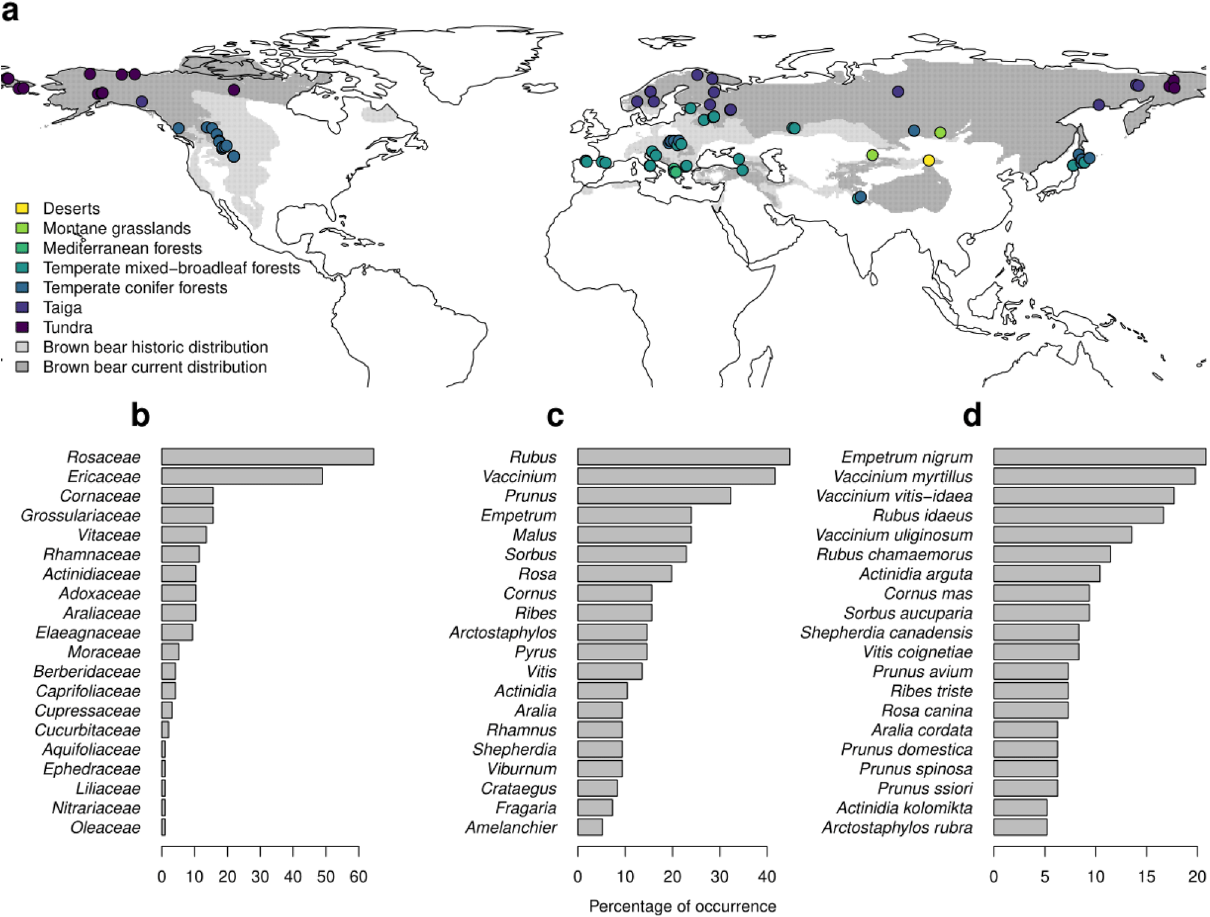
Figure 1. ( a ) Map showing the study areas (n = 96, dots) from which data on brown bear diet were gathered. Brown bear distribution is shown in grey. The dot colors represent the biomes in which each study area is located. The percentages of study areas with presence of different families ( b ), genera ( c ) and species ( d ) of fleshy fruits are shown in the lower panels. Only the 20 most common taxa of each taxonomic rank are shown. Study areas are listed in Appendix S6 and the complete list of taxa recorded in the brown bear diet worldwide is presented in Appendix S1. The map in ( a ) was created with the R statistical environment (version 3.4.0) 79 , using the package rworldmap 80 . Historical and present brown bear distributions were extracted from the IUCN website 81